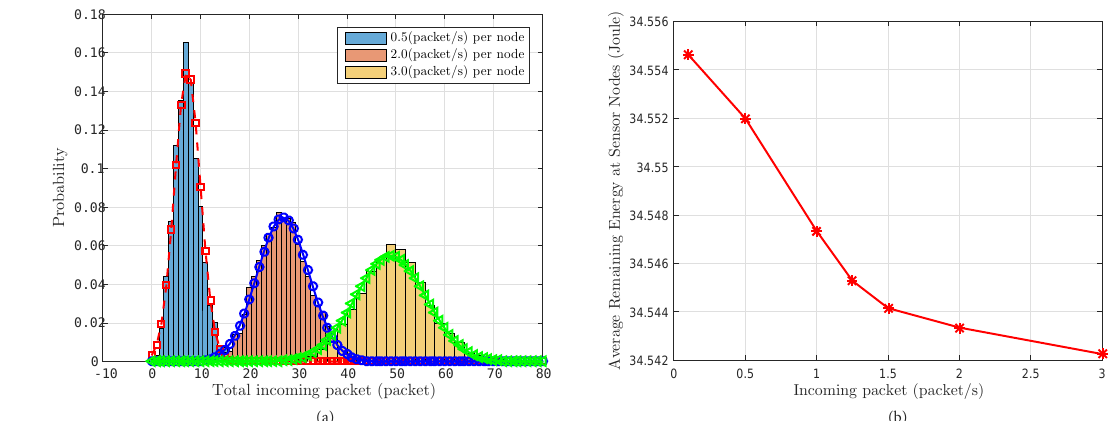
Figure 7: Force, Moment and Harvested energy at Hip, Knee and Ankle.